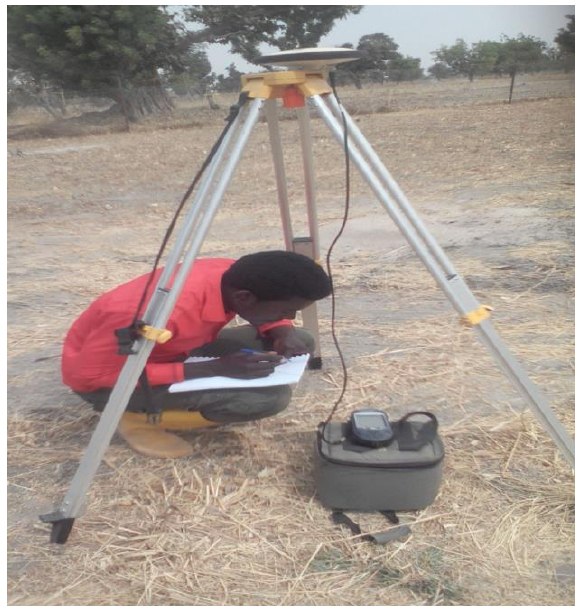
Fig. 2. Determining elevation in the research area using ProMark GPS